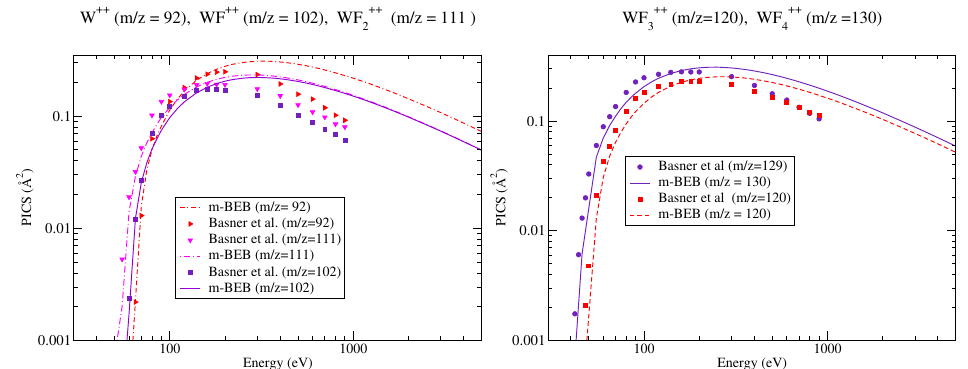
Figure 6. Partial ionization cross sections of DI cations of WF 6 for different m / z values. Line curves, m-BEB results; Symbols, DI PICS of Basner et al.